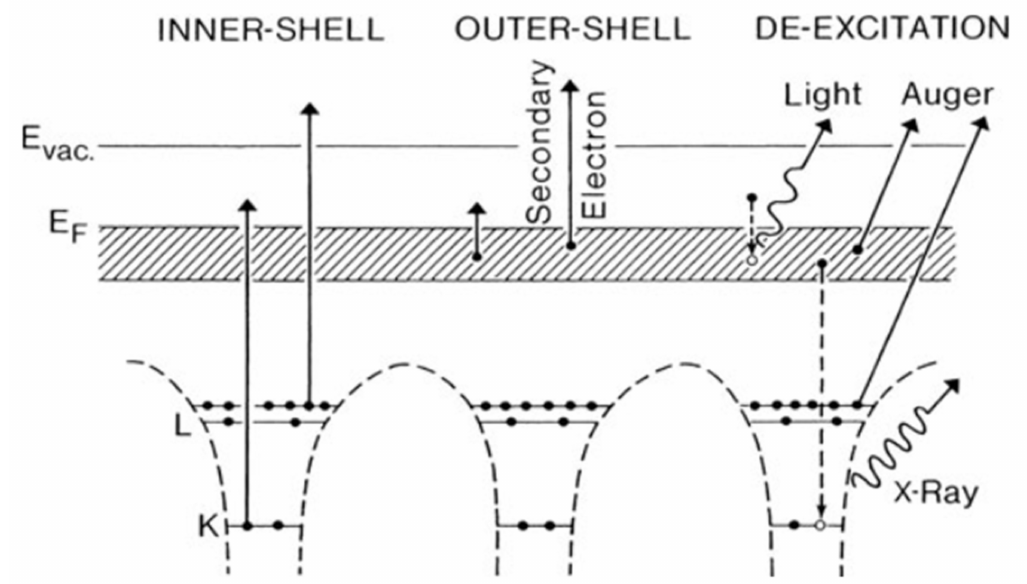
Figure 16. Energy-level diagram of a solid depicting K and L Shell and the valence band E f is the Fermi level and E vac is the vacuum level. The primary process of inner and outer shell excitation is shown on the left, the secondary processes from phonons and electrons on the right. [142]. Figure 16 reprinted by permission from Springer Nature Customer Service Centre GmbH: Springer Nature, Springer eBook, An Introduction to EELS, R.F. Egerton, Copyright © 2011, Springer Science Business Media New York.